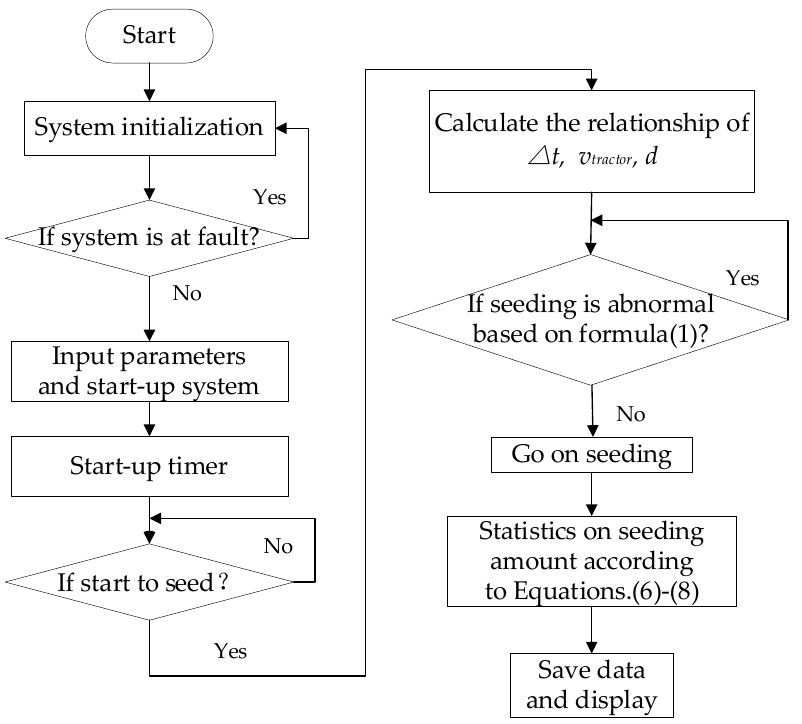
Figure 2. Monitoring system flow diagram.